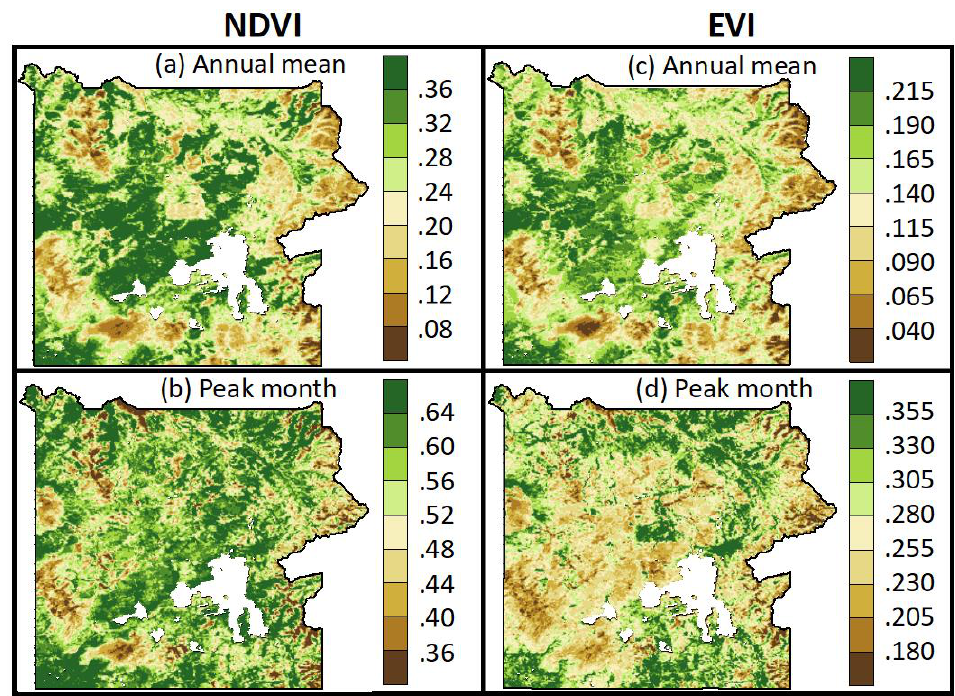
Figure 5. Statistics of Moderate Resolution Imaging Spectroradiometer (MODIS) greenness across Yellowstone for 2000–2017: ( a,b ) Normalized Difference Vegetation Index (NDVI) and ( c,d ) Enhanced Vegetation Index (EVI), including ( a,c ) annual mean vegetation indices (VIs) and ( b,d ) mean peak-month VI.